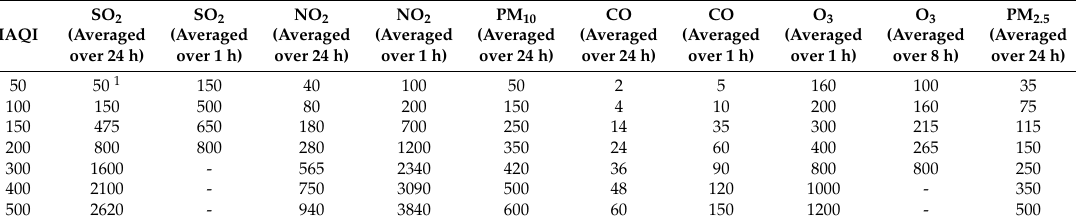
Table 2. Conversion between pollutant concentrations and IAQI.